Question: According to this chart, does the measure grow or shrink?
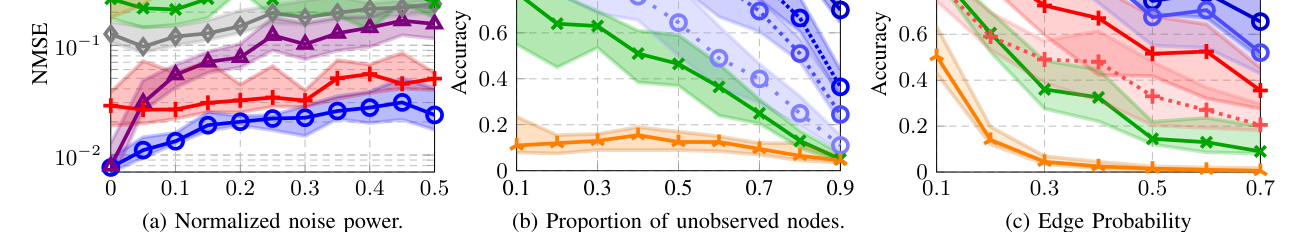
Answer: increasing